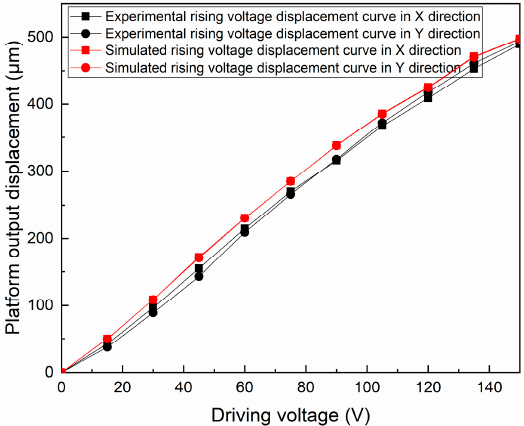
Figure 16. Relation curve between driving voltage and output displacement in experiment and simulation.